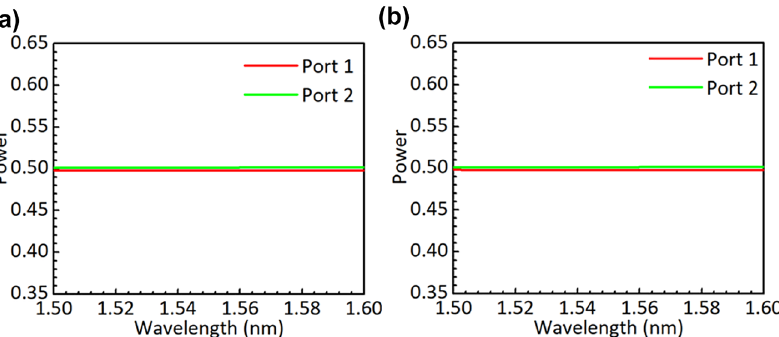
Figure 6: Simulated power splitting ratio of the designed power splitter for the TE 0 (a) and TE 1 (b)